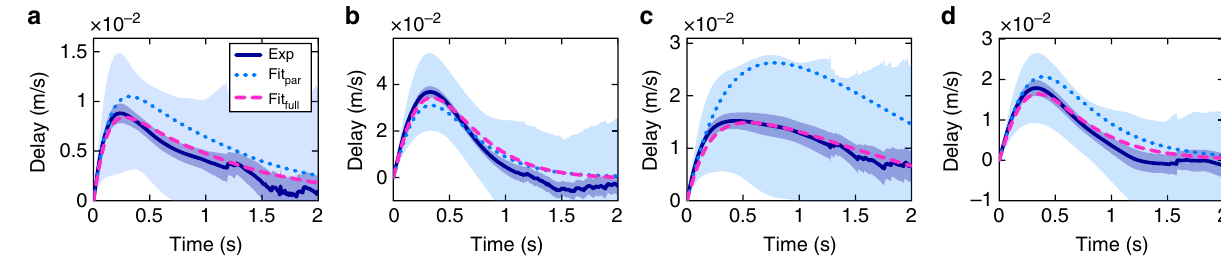
Fig. 4 Time-dependence of the delay function. Delay functions for the a generic, b carrier, c tug and d ring particle. The solid dark blue curve shows the experimental result. The light blue area expresses the standard deviation of the ensemble, the dark blue area illustrates the standard error (2 s.e.m). The dotted light blue curve is the theoretical expectation for the parameters from Fig. 3. The dashed magenta line is the theoretical expectation where the parameters have been obtained from a full fi t to velocity distributions, mean squared displacements and the delay function (see Supplementary